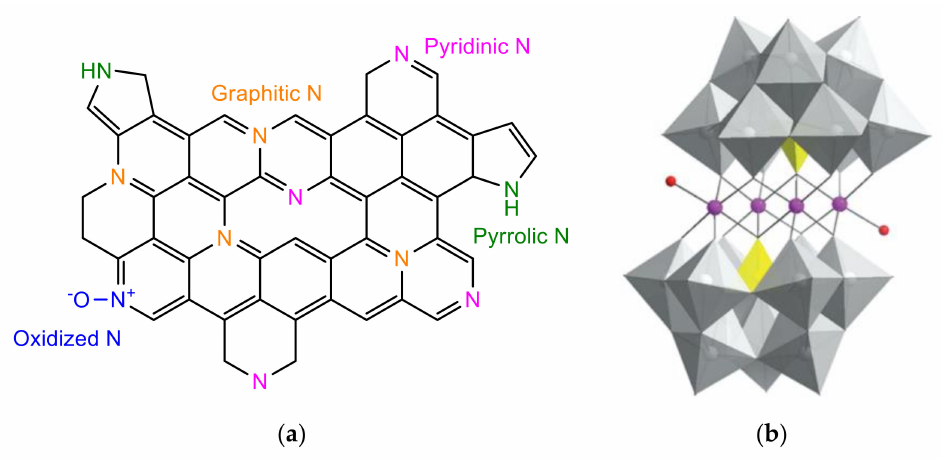
Figure 1. Schematic of N-types in graphene structure ( a ) and sandwich-type POM ( b